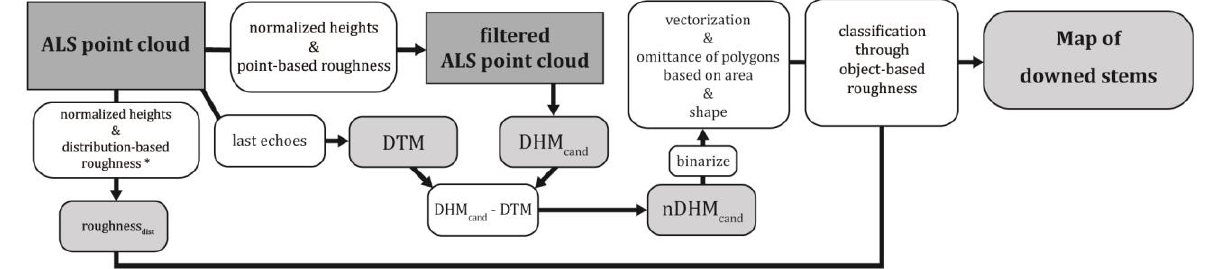
Figure 2 : Schematic depiction of the workflow for the detection of the downed stems. * distribution-based roughness features are either created from the full-waveform attribute echo width or 3D echo distribution features solely from discrete information (e.g. variance of normalized heights, RMS of normalized heights with respect to local horizontal plane, etc.) (modified from Mücke et al., 2013).